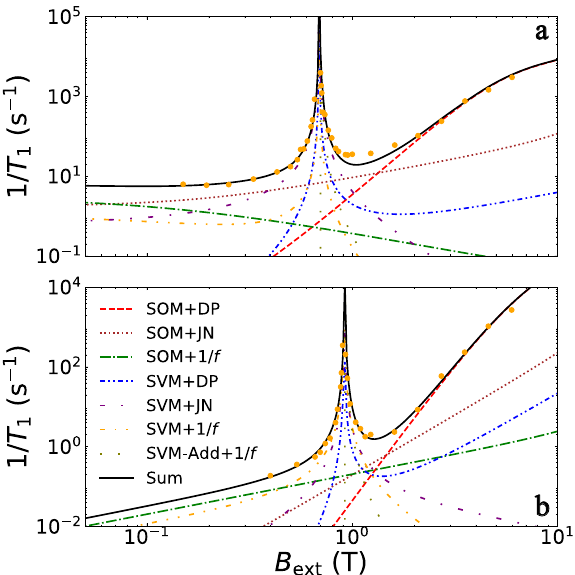
Fig. 4 Spin relaxation versus magnetic fi eld in silicon. Spin relaxation 1/ T 1 in a silicon QD as a function of the magnetic fi eld B 0 due to the s-SOC ( a ) or the i-SOC ( b ) and DP phonon, Johnson noise (JN), and 1/ f charge noise via the SVM or the intra-valley SOM. When E Z > E VS , we also include the additional spin relaxation from 1/ f charge noise (SVM-Add + 1/ f ) via an intermediate state, whose magnitude is appreciable near the hot spot but fast decreases as B 0 goes away from hot spot. The dots are the experimental data from ref. 38 . 1/ T 1 due to the s-SOC induced SVM (or intra-valley SOM) shows weaker dependence with B 0 than the case of the i-SOC, which explains the saturation of 1/ T 1 at low magnetic fi elds and the B 0 dependence at high magnetic fi elds when micromagnets